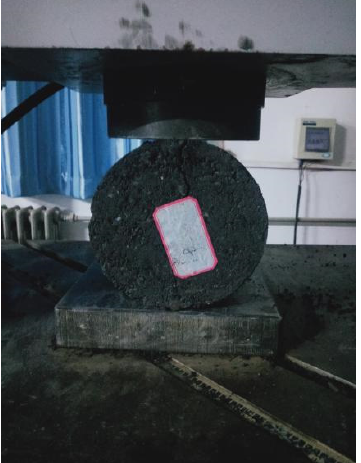
Figure 9. Splitting tensile test.